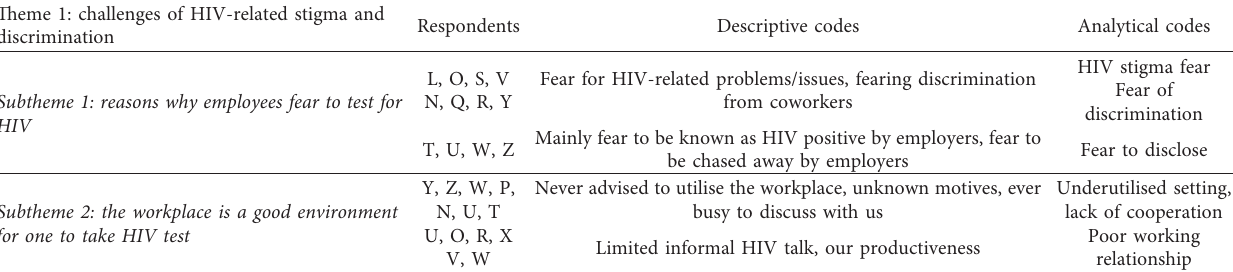
Table 2: An example of organisation of data by tabulation